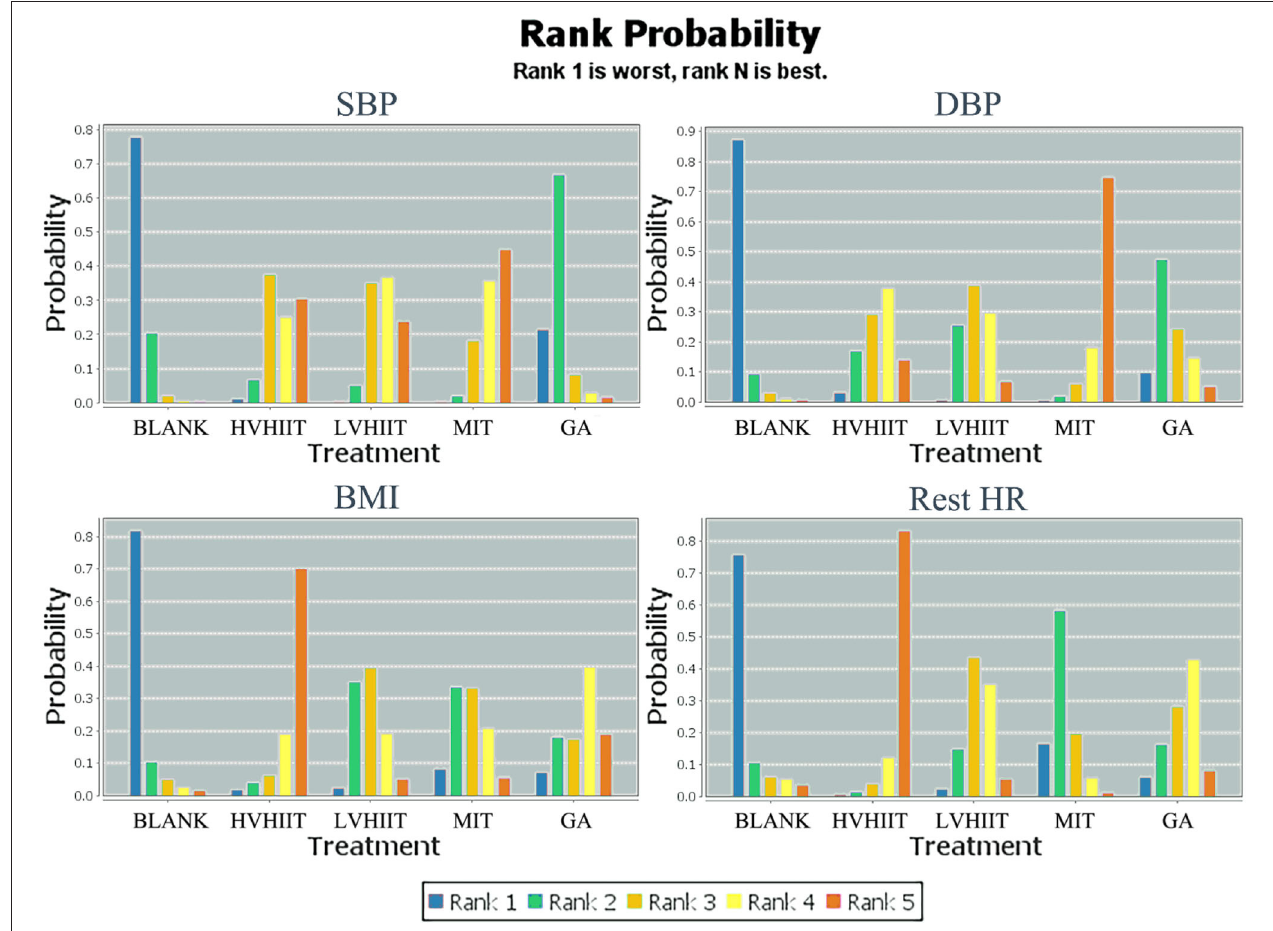
FIGURE 4 | Measurement of systolic blood pressure (SBP), diastolic blood pressure (DBP), body mass index (BMI), rest heart rate (HR), and the ranking of intervention probability. Blank, Blank control; LVHIIT, low-volume high-intensity interval training; HVHIIT, high-volume high-intensity interval training; MIT, Medium intensity training; GA, general physical activity.